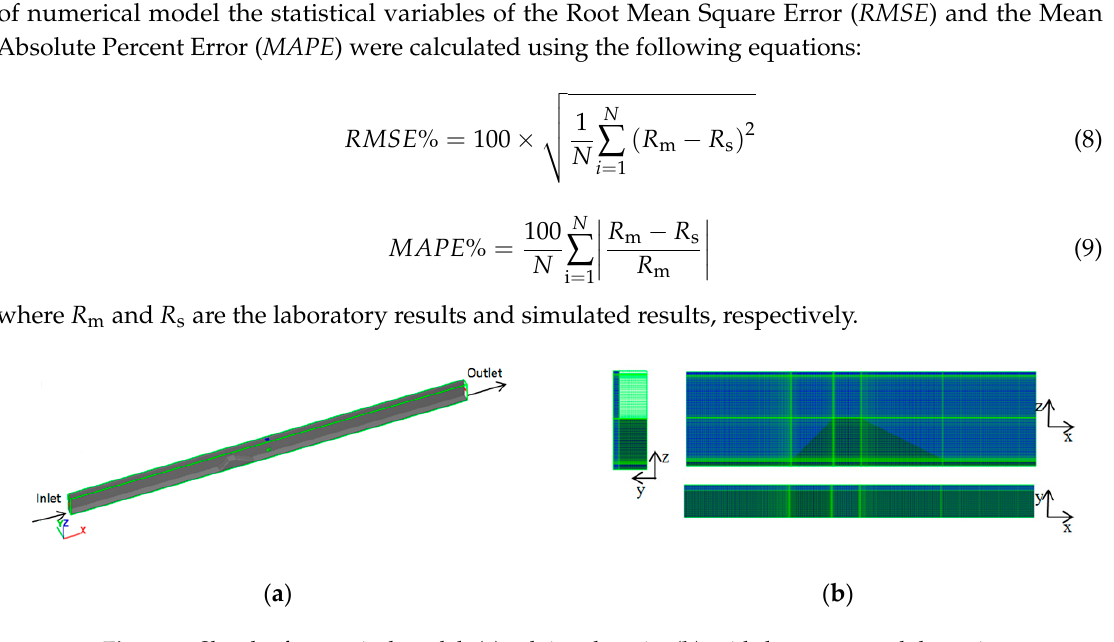
Figure 2. Sketch of numerical model: ( a ) solving domain; ( b ) grids layout around the weir. Table 1. Gridding characteristics, RMSE and MAPE for the simulated profiles of free surface. Meshing Number of Cells